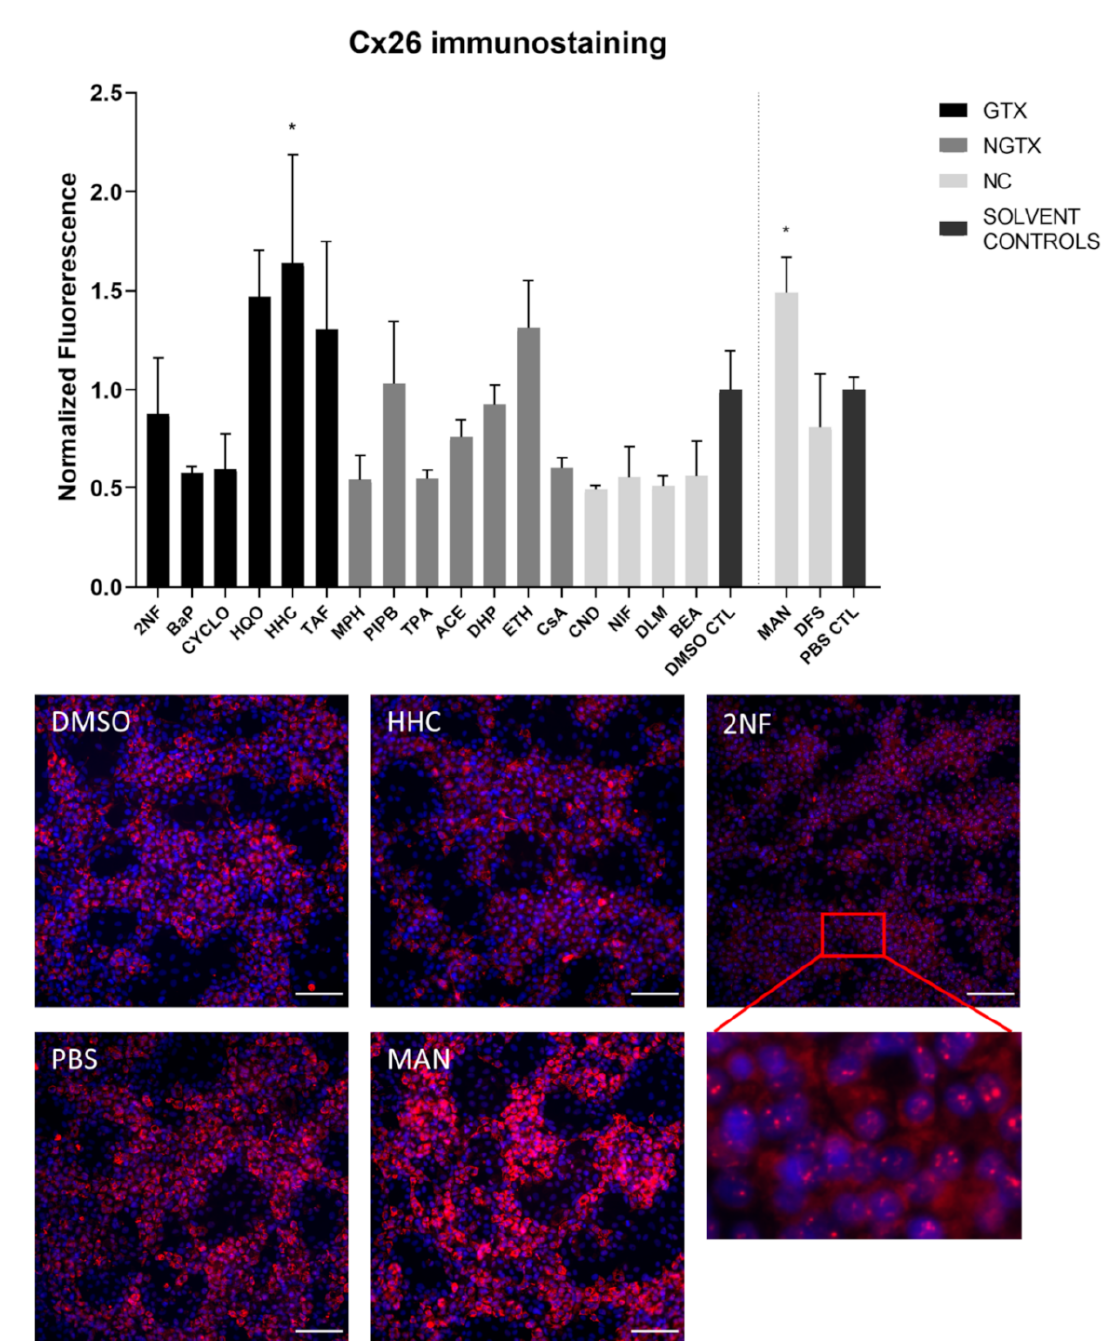
Figure 4. Cx26 protein localization in human hepatoma HepaRG cells exposed to GTX, NGTX, and NC chemicals. Human hepatoma HepaRG cells ( n = 1 and N = 1; at least three images per well) were exposed to GTX, NGTX, and NC chemicals for 72 h. The area and intensity of the fluorescent signal was quantified via ImageJ software (version 1.52p, Bethesda, MD, USA) and normalized to the fluorescent signal of the respective solvent control (DMSO CTL or PBS CTL). Significant difference compared to the solvent control was calculated with a parametric one-way ANOVA followed by a Dunnett’s post-hoc test to correct for multiple comparisons. Data are expressed as mean ± standard deviation with * p ≤ 0.05. Only images of significantly affected chemicals and 2NF are shown. Scale bar = 100 µ M, 20 ×